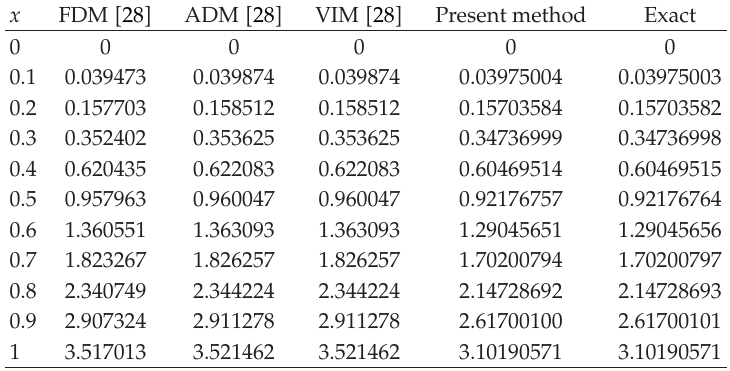
Table 3: Comparison of solutions for Example 3.1, Case 4.